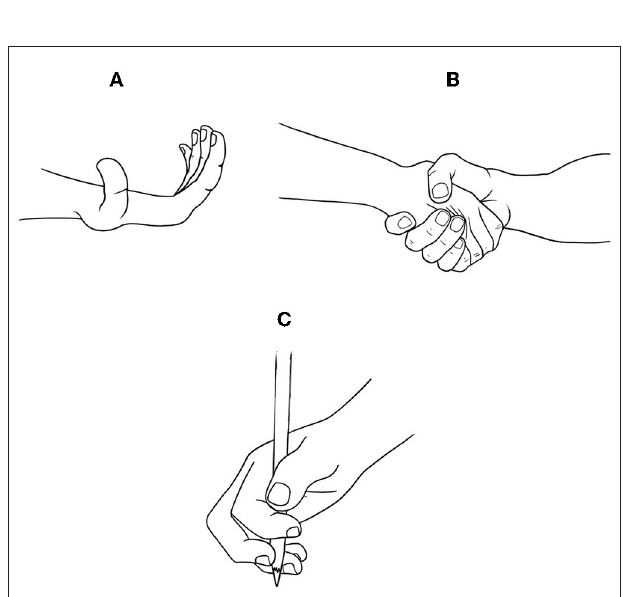
FIGURE 2 | Illustration of the flying bird hand (A) , greeting sign (B) , and adaptation for writing (C) .